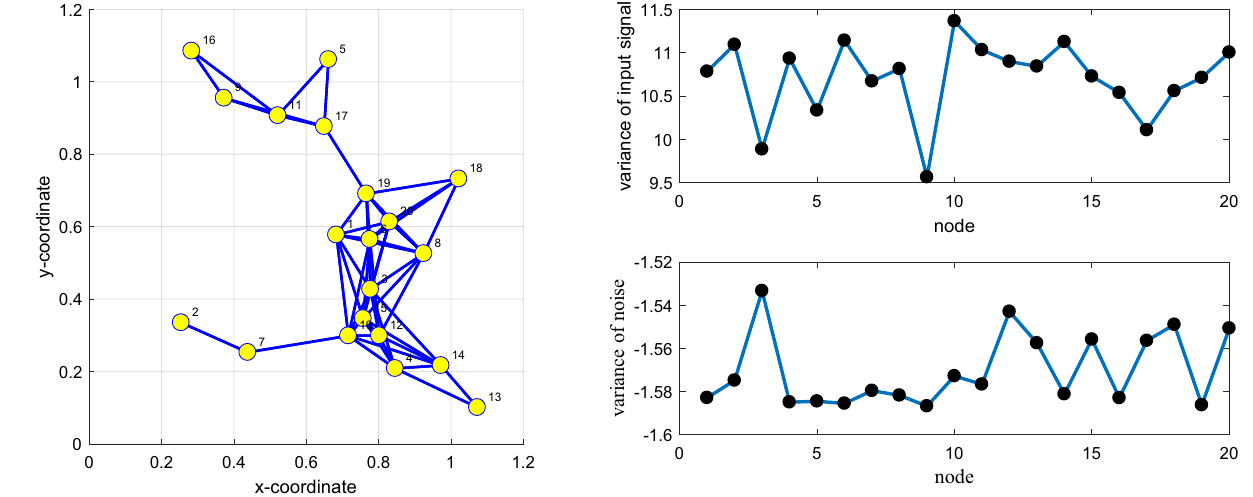
Figure 11. (Left) Random network topology to be decided by a certain radius; (Right_top) the input signals { X n ( i ) } variances of at each network node with R xx , n = σ 2 measurement interference variances ε n ( t ) at each network node.